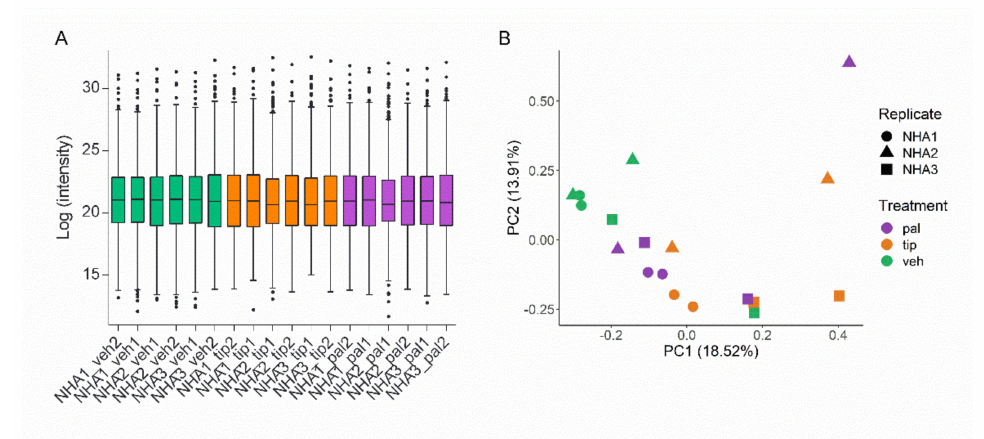
Figure 1. Protein expression profile in normal human astrocytes (NHA) under lipotoxic treatments. Three biological (NHA 1 to 3) and two technical replicates were cultured in medium alone (veh), medium containing palmitic acid (pal), or medium containing tibolone 10 nM pre-treatment and palmitic acid 2 mM (tip). ( A ) Tukey boxplot of Protein abundance by sample, normalized with VSN method. ( B ) Principal component analysis (PCA) to evaluate the relationships between biological replicates and treatments. Green: veh samples, orange: tip samples, and violet: pal